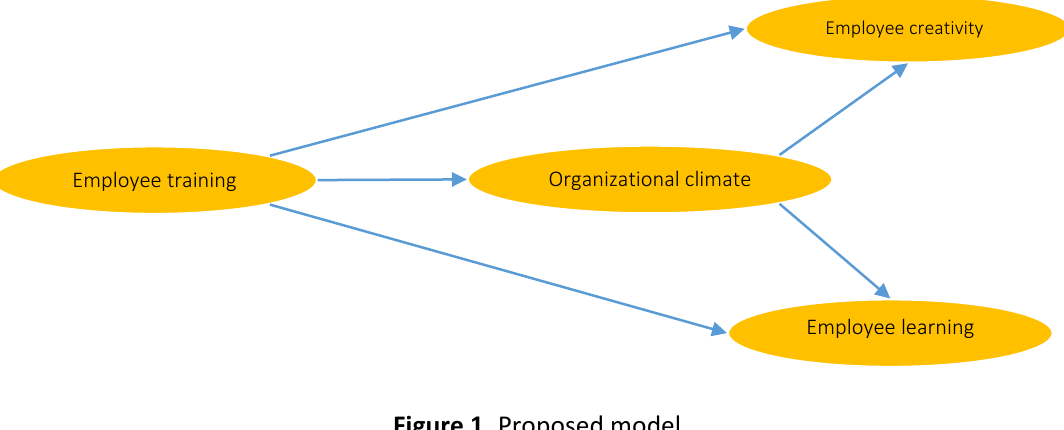
Figure 1. Proposed